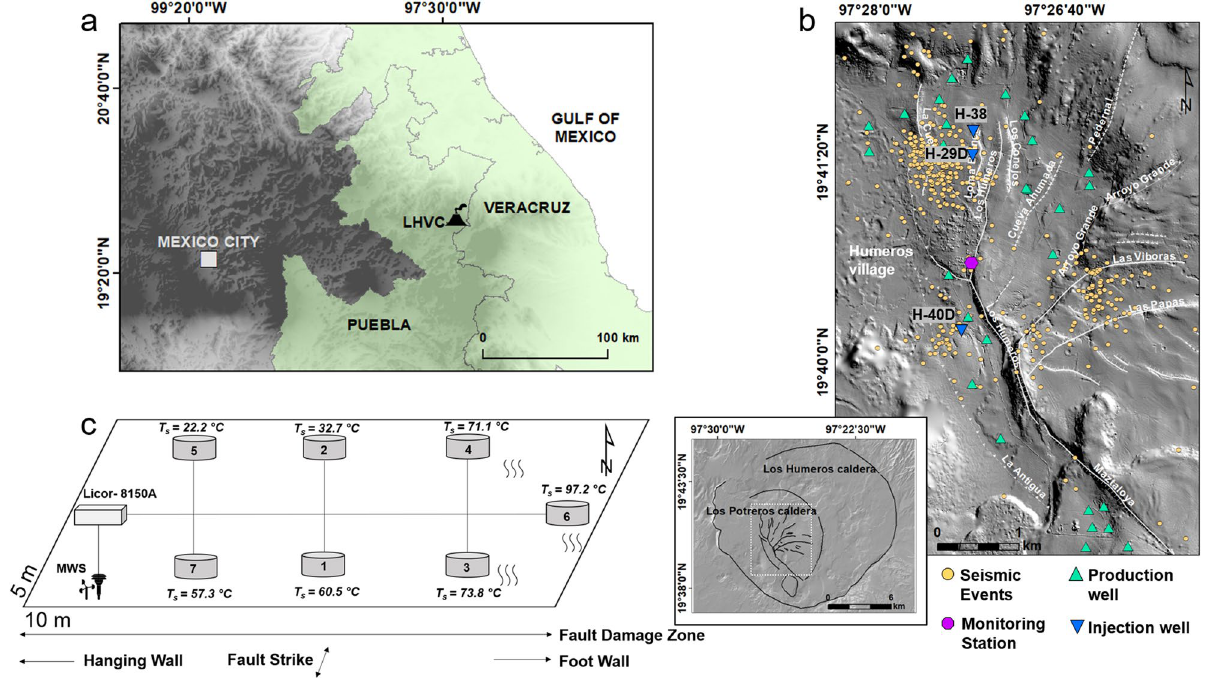
Figure 1. ( a ) Location of the Los Humeros Volcanic Complex (LHVC) on the border of the federal states Puebla and Veracruz on a 120 m-resolution digital elevation model (DEM), available at https:// www. inegi. org. mx/ app/ geo2/ eleva cione smex/. ( b ) Overview of the main production field of Los Humeros (Installed capacity 93.9 MWe 21 ) on a shaded relief image obtained from a 1 m-resolution DEM 22 . White solid and dashed lines illustrate known and inferred faults, respectively. Orange circles represent locations of seismic events from September 2017 to September 2018 23 . The inset map, illustrated by the white dashed rectangle, shows the extent of the LHVC and Los Potreros calderas hosting the active geothermal field. The maps were generated using ArcGIS 10.4.1 software. ( c ) Setup of the CO 2 monitoring array within the fault damage zone of the Los Humeros fault. Ts values indicate ground temperatures measured during the initial site selection survey, while black arrows show the direction and extension of fault geometry